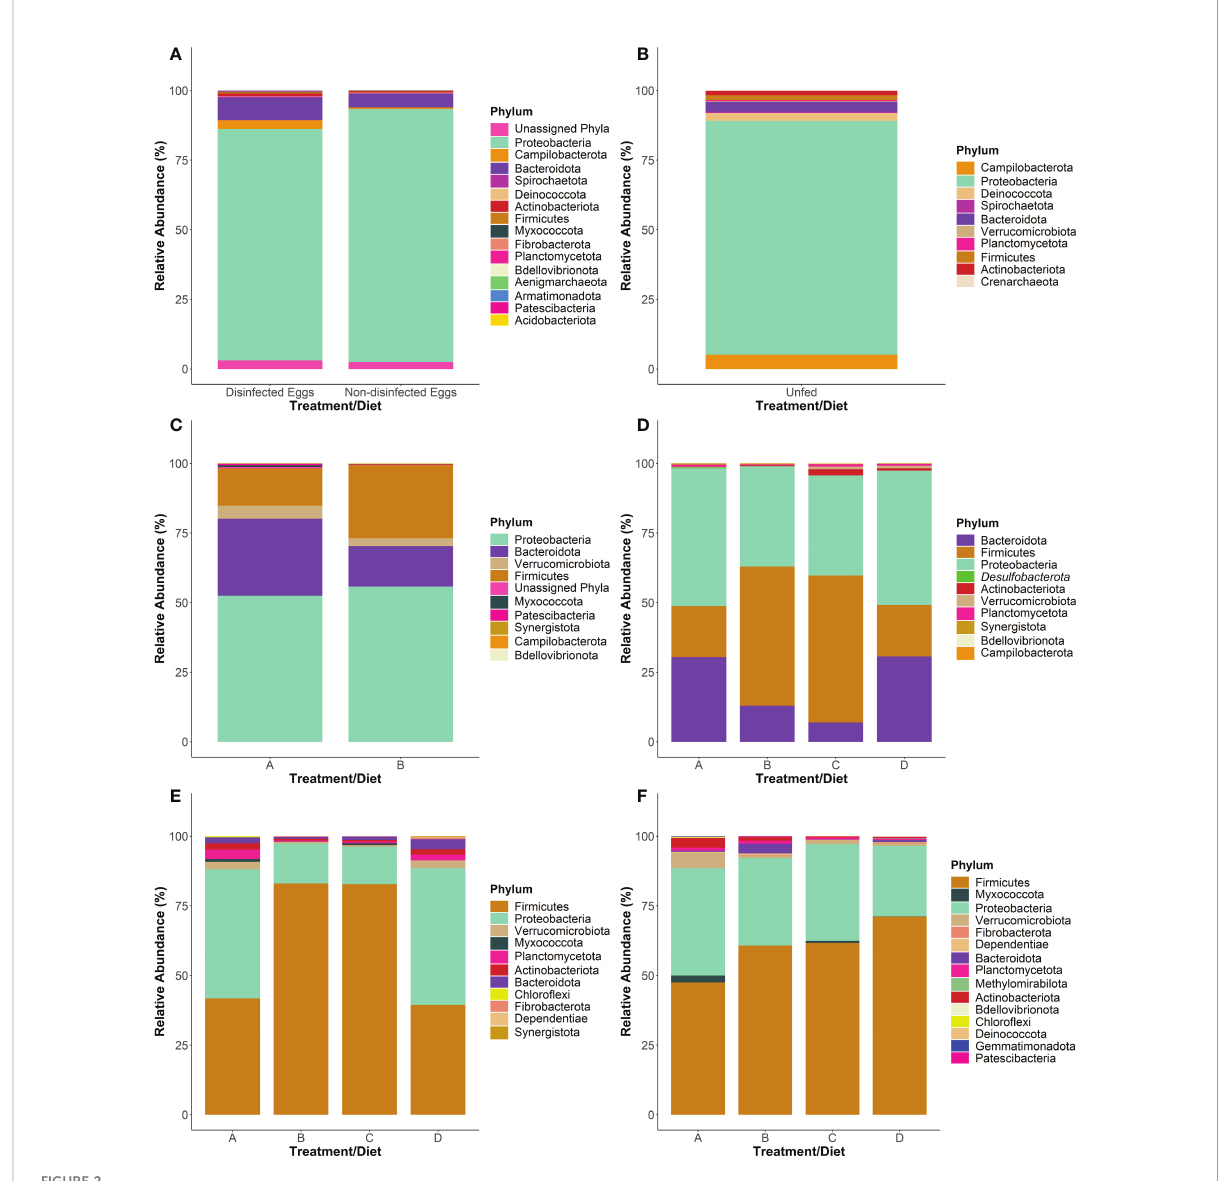
FIGURE 2 Phylum-level taxonomy of the internal bacterial microbiome of steelhead trout throughout a probiotic feeding regime. The 16S rRNA gene V4 region was sequenced at various points throughout the early lifecycle of steelhead trout at fi ve timepoints where the total intestinal microbiome was examined: (A) T-1, (B) T0, (C) T1, (D) T2, (E) T3 intestinal homogenate samples. The adherent intestinal microbiome was analyzed at one time point: (F) T3 intestinal swab samples. Plots represent the top phyla comprising at least 90% of the total microbiome for all treatment groups. Bars were constructed using the average reads from samples speci fi ed as: fi ve non-disinfected eggs, six disinfected eggs, 10 T0 internal homogenates, 10 T1 internal homogenates, eight T2 intestinal homogenates, 12 T3 intestinal homogenates, 10 T3 intestinal swabs for diets A, B, and D, and nine T3 intestinal swabs for diet